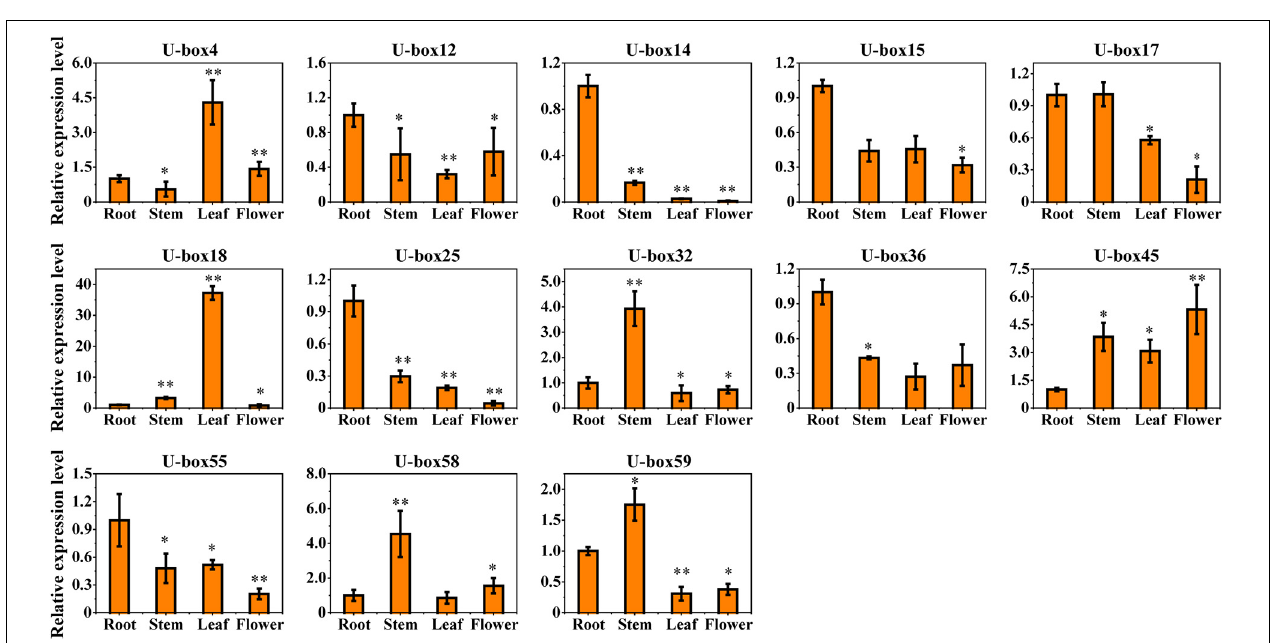
FIGURE 6 | The expression profiles of 13 selected U-box genes in different vegetative and reproductive tissues. Asterisks indicate significant differences in the root vs. other tissues by t -test with two significant levels ( ∗∗ P < 0.01; ∗ P < 0.05), and the data presented the average of three replicates.